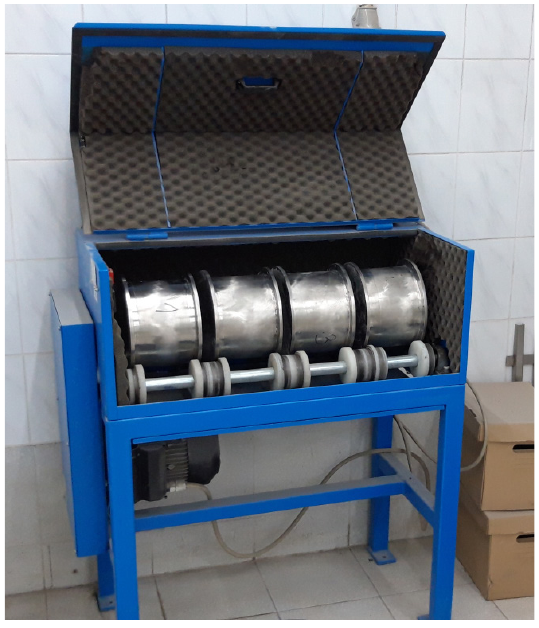
Figure 4: Micro-Deval drum.